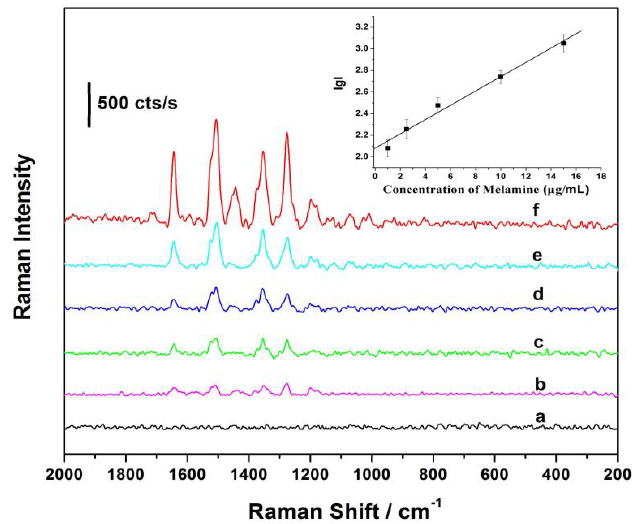
Figure 8. Raman spectra of [Fe 3 O 4 /Au–AOA ••• melamine ••• AOA–RhB] in water at melamine concentration of 0 µg/mL ( a ), 1.0 µg/mL ( b ), 2.5 µg/mL ( c ), 5.0 µg/mL ( d ), 10.0 µg/mL ( e ), and 15.0 µg/mL ( f ). (Inset: logarithmic linear correlation of peak intensity at 1510 cm −1 and melamine concentrations).